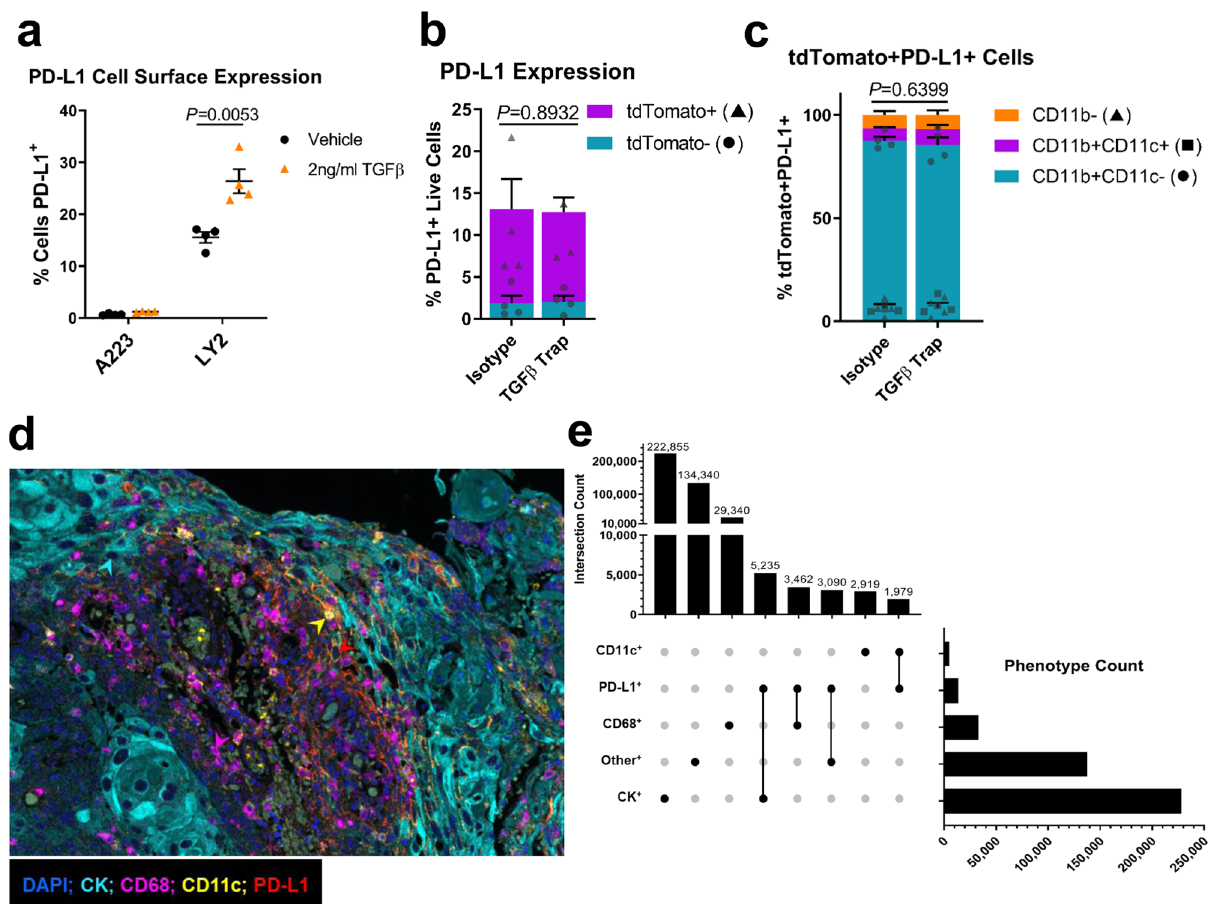
Fig. 2 Spatial patterns of PD-L1 + cells in mouse and human SCCs demonstrate that in fi ltrating leukocytes are the primary source of PD-L1 within tumors. a Percentage of PD-L1 + A223 and LY2 cells after stimulation with 2 ng/ml recombinant TGF β (orange triangles, n = 4) or PBS vehicle (black circles, n = 4) as measured by fl ow cytometry. b tdTomato expression (purple bars: positive, blue bars: negative) in PD-L1 + live cells isolated from mTmG mice bearing A223 tumors and treated with TGF β trap control isotype control 3×/week for 1 week, as quanti fi ed by fl ow cytometry ( n = 5 per treatment group). c Analysis of CD11b and CD11c expression of tdTomato + cells from c as quanti fi ed by fl ow cytometry (CD11b + CD11c − : blue bars, CD11b + CD11c + : purple bars, CD11b − : orange bars, n = 5 per treatment group). d Representative tumor from multispectral imaging analysis of 23 human HNSCC tumors stained for pan-cytokeratin (cyan), CD68 (magenta), CD11c (yellow), PD-L1 (red), and DAPI (blue). Arrowheads represent example phenotypes using the same color code. e Table of total number of cells of each indicated phenotype across all samples in ( d ) (horizontal bars), and counts of cells that overlap one or more phenotypes (vertical bars). The central matrix displays the combinations graphically with connected dots indicating overlapping phenotypes. Unpaired two- tailed t tests were performed for ( a – c ), and all error bars represent the SEM. Raw unstacked values in ( b ) and ( c ) are represented by the indicated